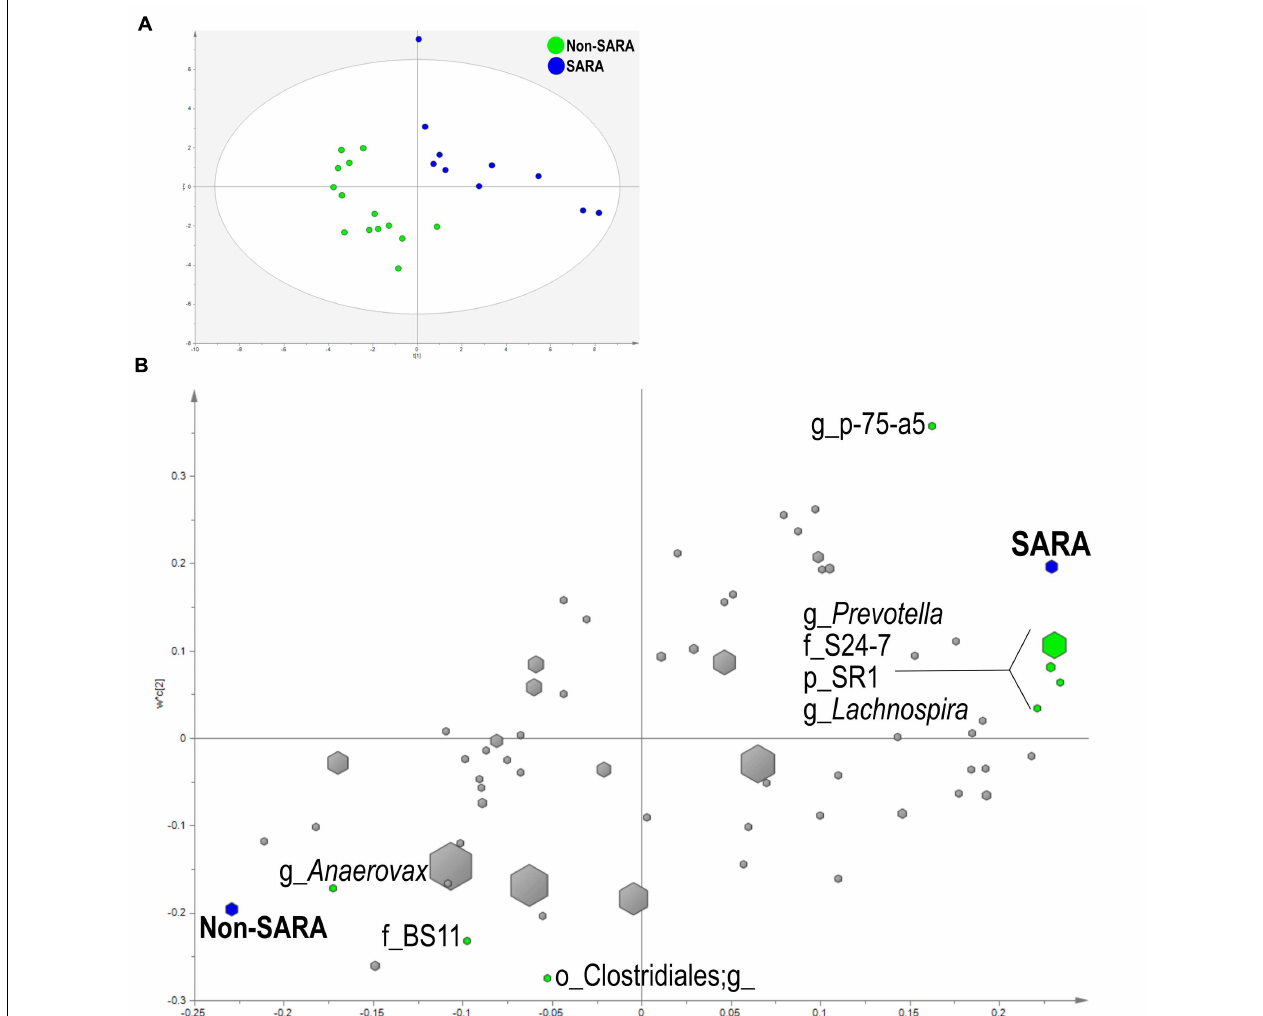
FIGURE 4 | Partial least squares discriminant analysis model of the solid fraction bacterial communities with three components. (A) PLS-DA score scatter plot discriminating between Non-SARA and SARA cows in the solid fraction [goodness-of-fit parameter (R 2 ) (Y) = 0.94; predictive ability parameter (Q 2 ) (cum) = 0.62] with each point representing a single sample. (B) PLS-DA loading scatter plot of bacteria classified to the lowest taxonomic level. Taxa with significant coefficient values (relationship between X and Y variables) are labeled. The size of each point corresponds to the average relative abundance of the taxa. Letter prefix denotes the lowest level of taxonomic identification [genus (g); family (f); order (o); and phylum